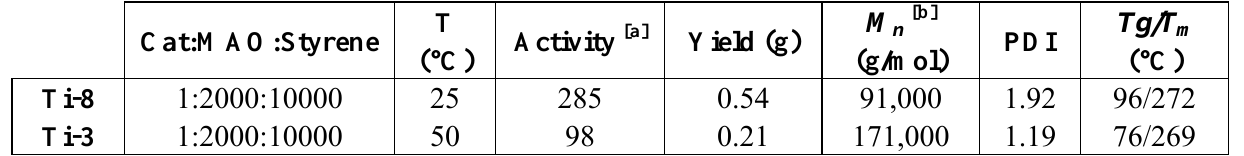
Table 3. Homopolymerization of styrene using Ti-8 and Ti-3